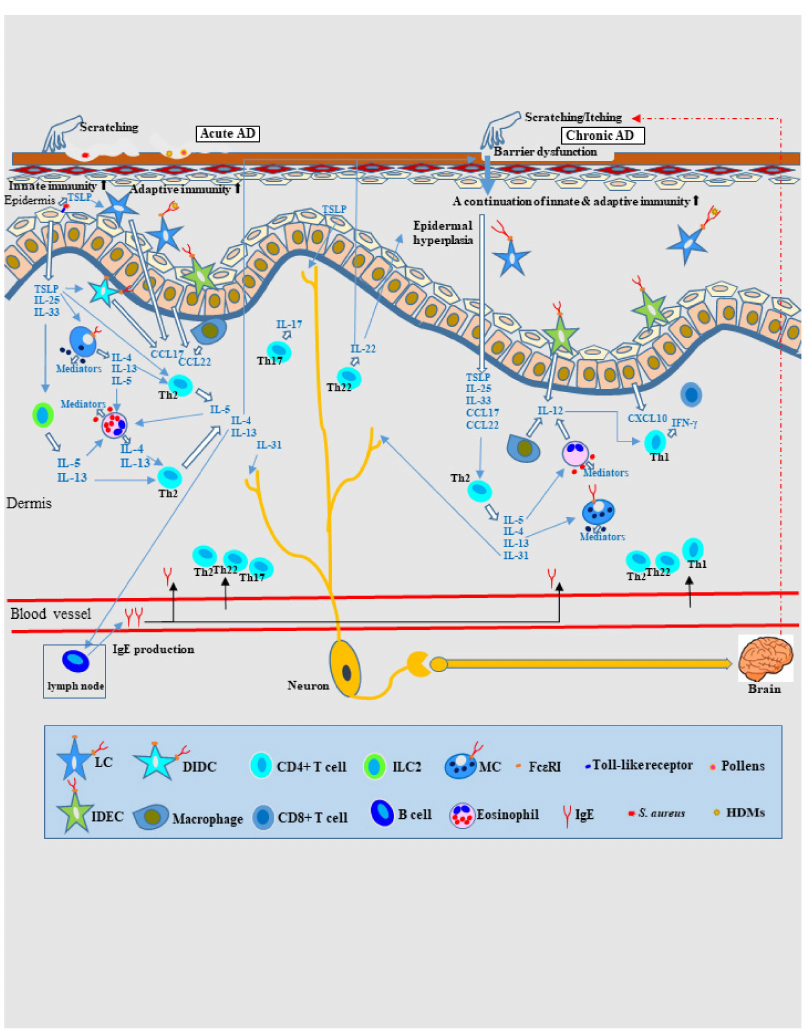
Figure 1. Schematic illustration of the cytokine milieu of type-2 – dominant immunity axes in AD. In AD, both innate and adaptive immune responses are activated. Environmental stimuli (e.g., scratching and dysbiosis involving S. aureus ) induce the release of type-2 (Th2) inflammation- promoting chemokines (e.g., TSLP, IL-25, and IL-33) from keratinocytes, and innate effector cells (e.g., DCs, MCs, and ILC2s) are activated to secrete type-2 cytokines and chemokines, ultimately inducing the recruitment of Th2 cells in lesioned skin. In adaptive immunity, T cell-mediated biphasic immune reactions develop. Th2 cytokines (i.e., IL-4, IL-5, IL-13, and IL-31), Th22 cytokines (i.e., IL-22), and Th17 cytokines (i.e., IL-17) are involved in acute lesions, and progressive activation of Th2 and Th22 cytokines and significant upregulation of Th1 cytokines (i.e., IFN- γ ) occur in chronic lesions. For the recruitment of Th1 cells, IL-12 secretion is needed in lesioned skin, and macrophages, eosinophils, and DCs are thought to be sources of these cytokines. In both acute and chronic lesions, Th2 cytokines play many roles: for example, IL-4 and IL-13 stimulate B cells to produce IgE and promote IgE binding to MCs and DCs (e.g., LCs and IDECs); IL-5 increases eosinophil viability; and IL-31 and TSLP cause itching by directly acting on peripheral nerves. In addition, IL-4, IL-13, and the Th22 cytokines IL-22 induce epidermal barrier dysfunction. The Th22 cytokine IL-22 also induces epidermal hyperplasia in chronic lesions. Abbreviations: AD, atopic dermatitis; CCL, CC chemokine ligand; CD, cluster of differentiation; CXCL, CXC chemokine ligand; DC, dendritic cell; DIDC, dermal inflammatory dendritic cell; Fc ε RI, high-affinity IgE receptor; HDMs, house dust mites; IDEC, inflammatory dendritic epidermal cell; IgE, immunoglobulin E; IL, interleukin; ILC2, type-2 innate lymphoid cell; LC, Langerhans cell; MC, mast cell; S. aureus , Staphylococcus aureus ; Th, T helper; and TSLP, thymic stromal